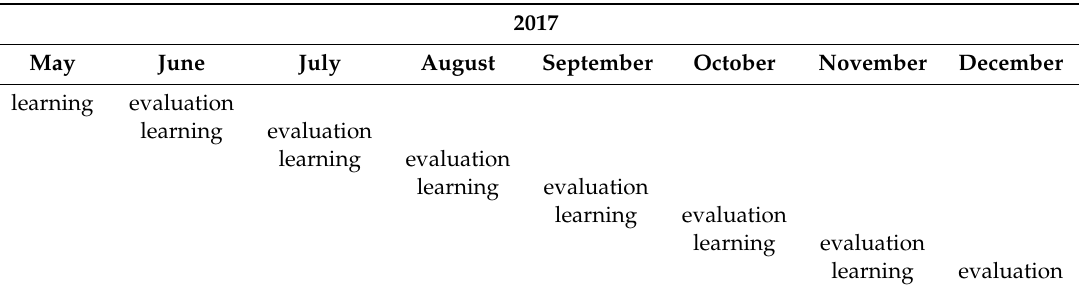
Table 11. Relationship between learning period and evaluation period.